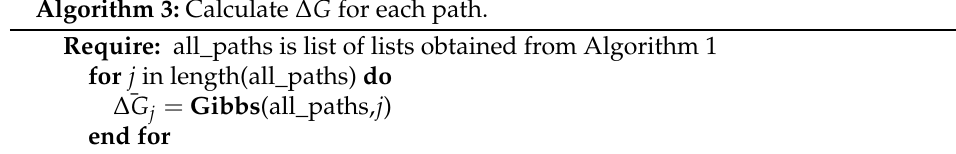
Algorithm 3: Calculate ¯ ∆ G for each path.